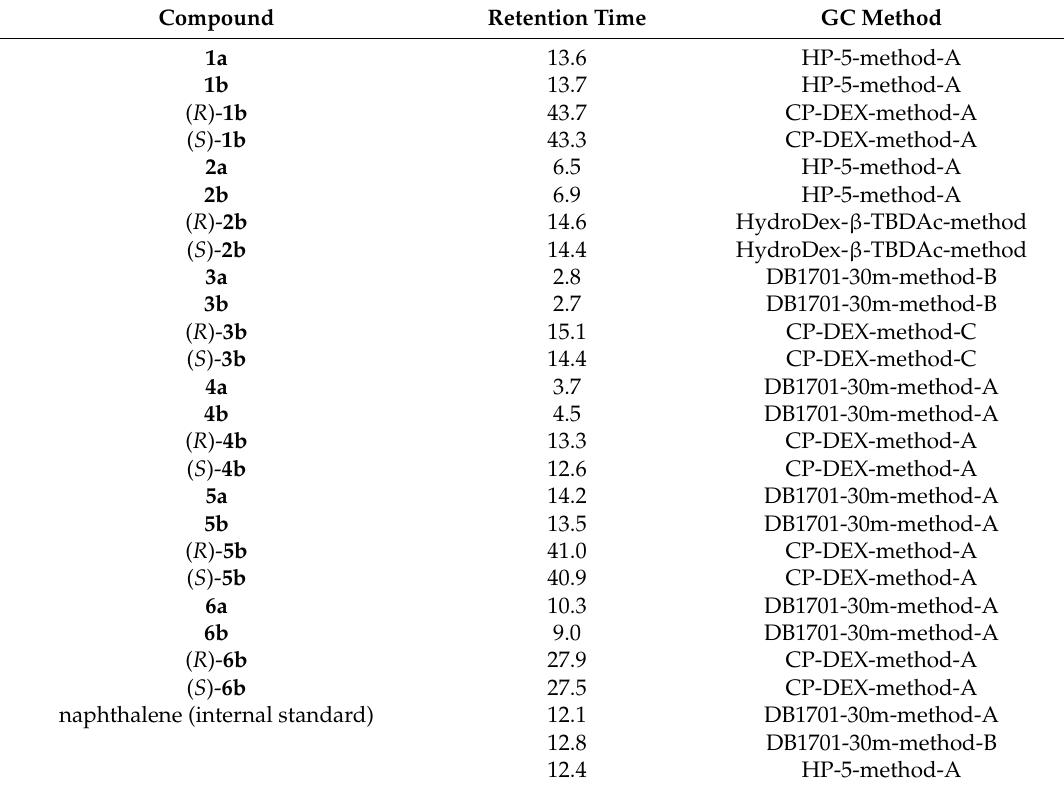
Table A4. GC retention times and